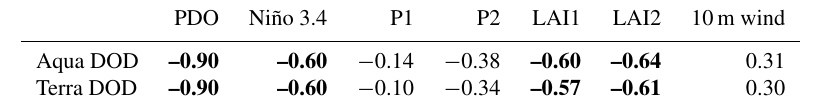
Table 2. Same as Table 1 but for MAM average from 2003 to 2015 (or 2014). Coefficients significant at the 95% confidence level are in bold.